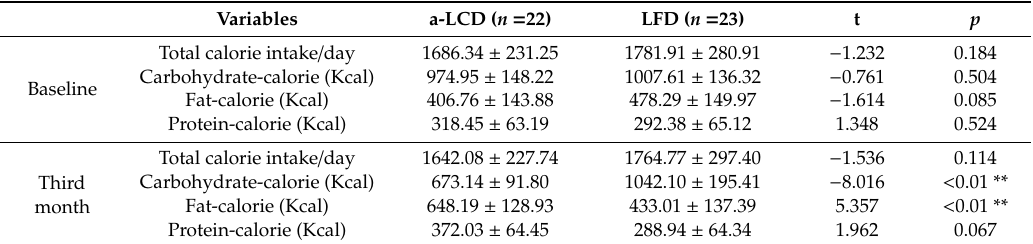
Table 2. Comparison of the calories from three macro-nutrients consumed by the patients.